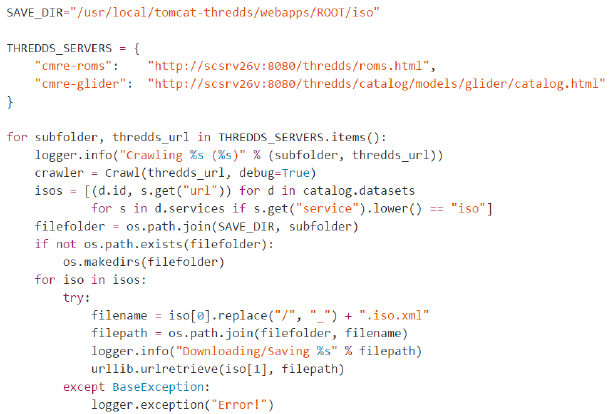
Figure 2. Snippet of Python code to crawl THREDDS